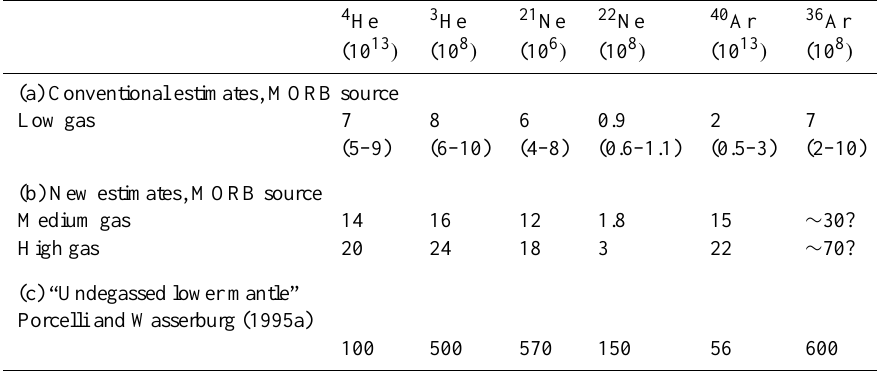
Table 1. Noble gas